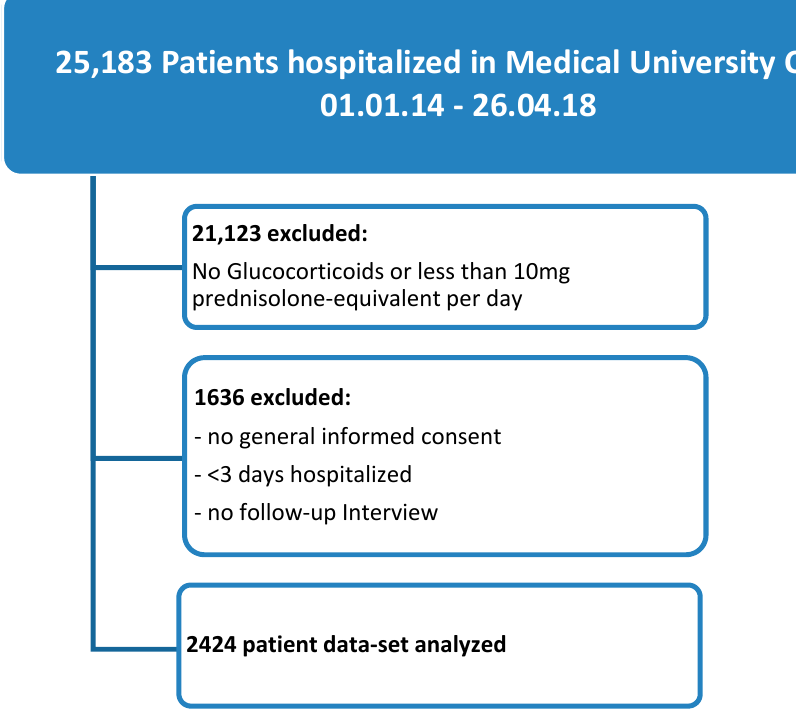
Figure 1. Study flow diagram.